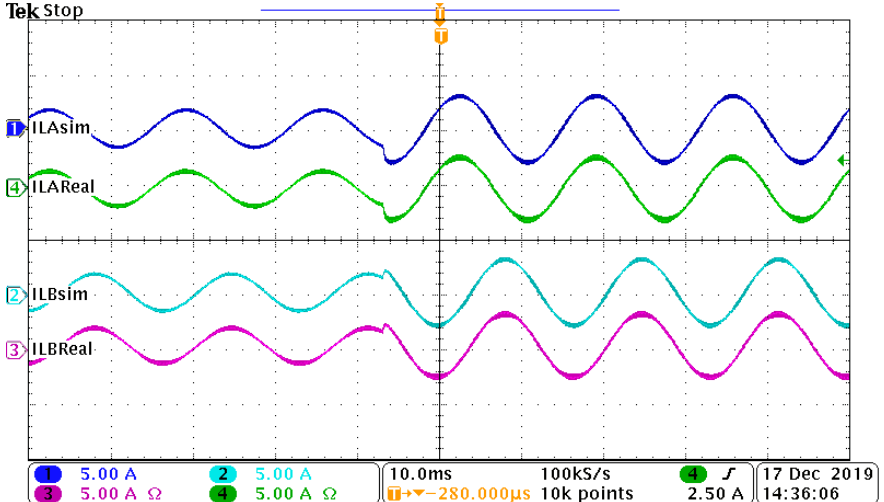
Figure 19. Output currents ( i a and i b ) of the three-phase VSI and HIL simulation, simulated i a current (Channel 1), simulated i b current (Channel 2), real i b current (Channel 3), and i a real current (Channel 4).